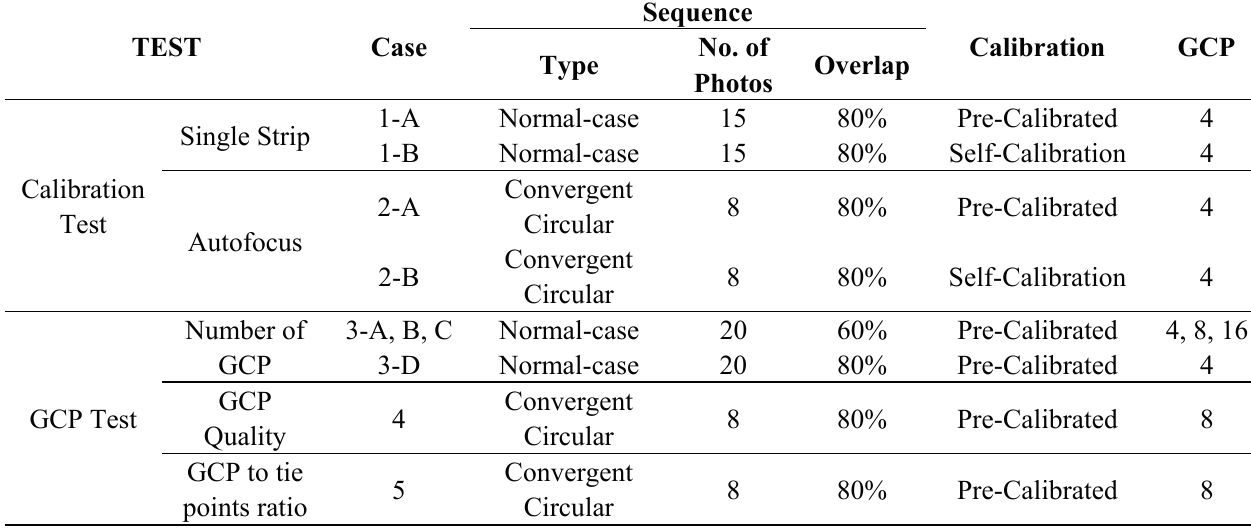
Table 1. Summary of Monte Carlo (MC) simulations carried out, including investigated